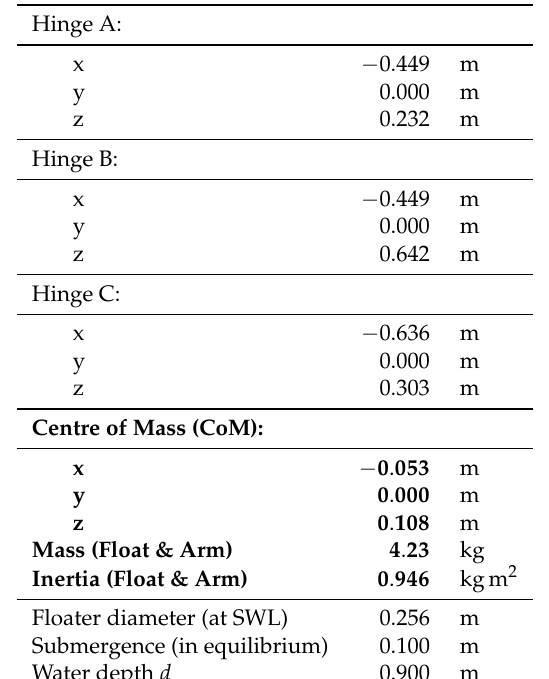
Table 1. Physical properties of the 1/20th scale Wavestar model. All measurements taken from [11] are printed in